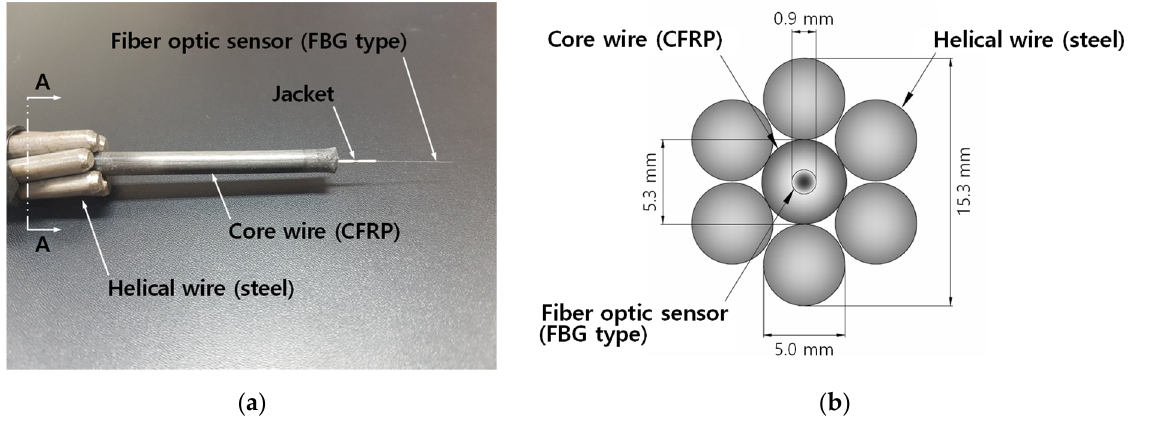
Figure 1. Configuration and dimensions of a Smart Strand: ( a ) configuration; and ( b ) section A–A and dimensions.